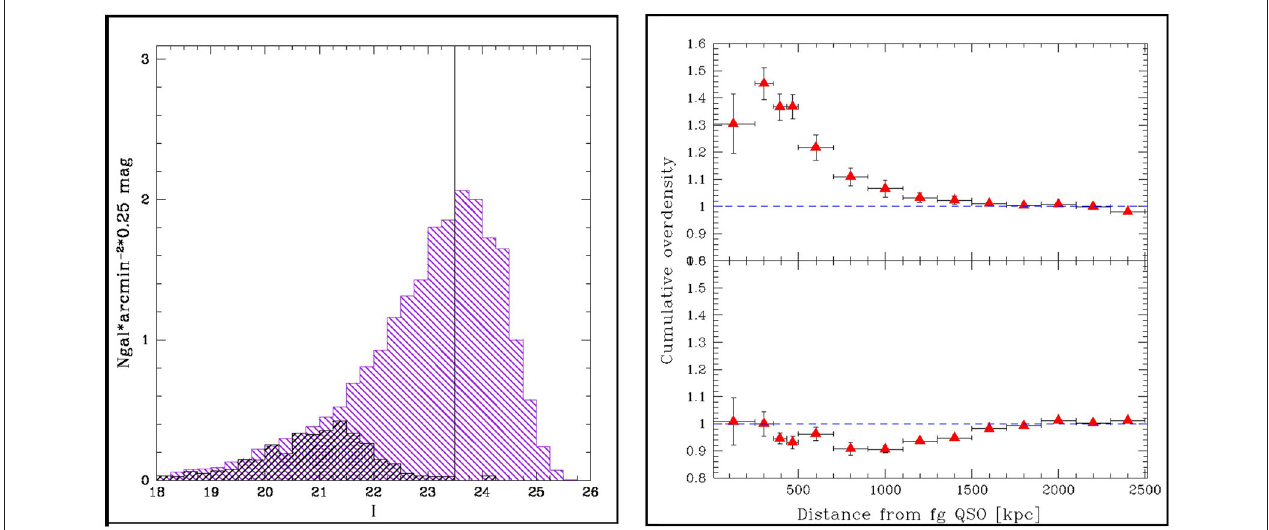
FIGURE 3 | Left : Average surface number density of galaxies vs. I magnitude of 8 quasar pair fields obtained at VLT FORS2. The vertical line marks the adopted threshold magnitude for the environment study. For comparison the black histogram shows the similar distribution based on the SDSS analysis of 5 fields. Right : Average cumulative overdensity of galaxies around quasars (see Table 1 ). Only half of quasars exhibits a clear galaxy overdensity (upper panel) while the other half does not show any overdensity (lower panel).